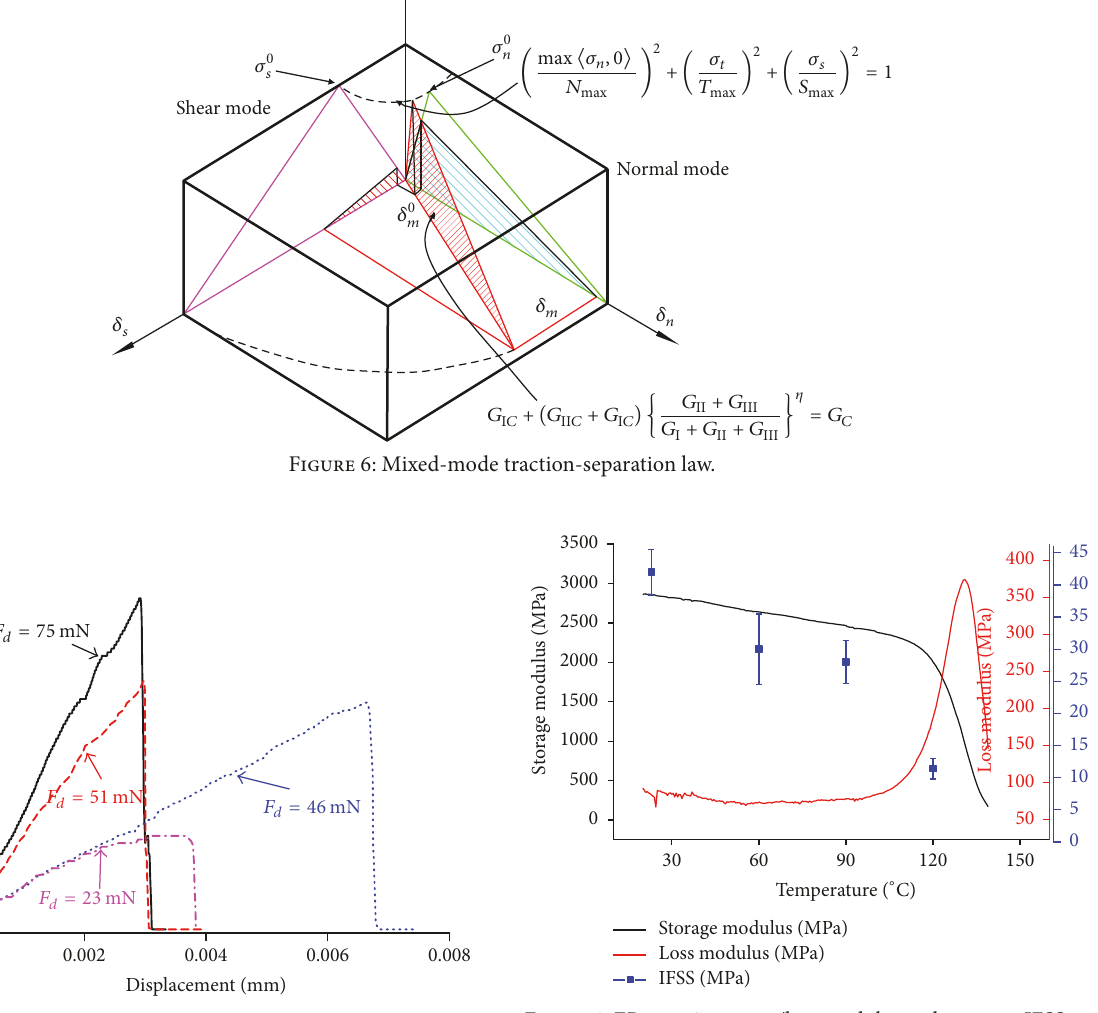
Figure8:EPsmatrixstorage/lossmodulusandapparentIFSSversus